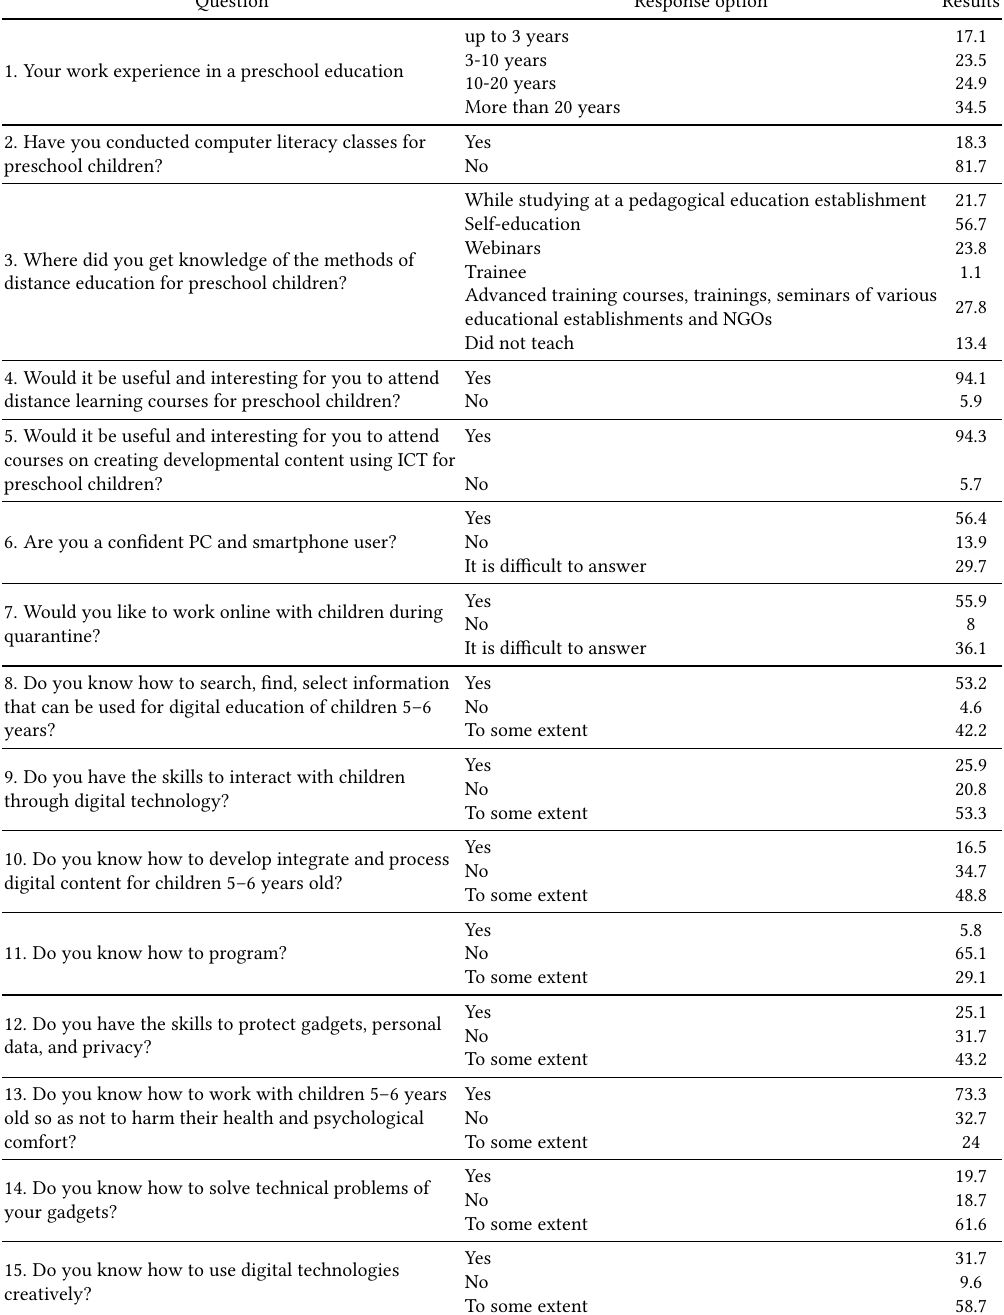
Table 1 Teachers survey